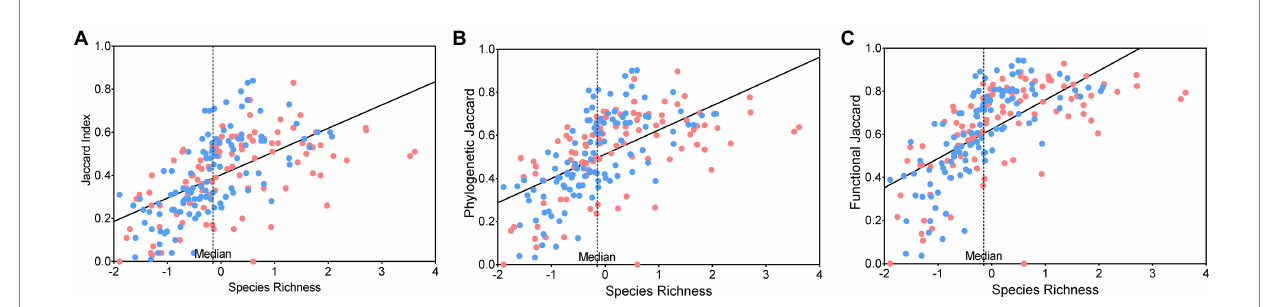
FIGURE 1 Scatter plots and ordinary least squares (OLS) model fitting line of relationships between the (A) species Jaccard index, (B) phylogenetic Jaccard index, and (C) functional Jaccard index and bird species richness in the species inventories compiled from combined datasets. The color of the points indicates the relative size of the number of species contributed by the “observational dataset” and “avifauna dataset” without the shared species. Specifically, a city with a red point indicates that the number of additional species contributed by the observational dataset is greater than that of the avifauna dataset and vice versa.